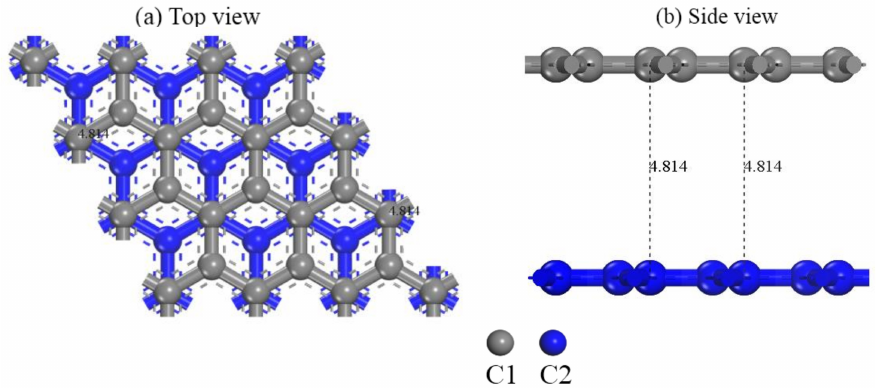
Figure 1. Optimized configuration of graphite before